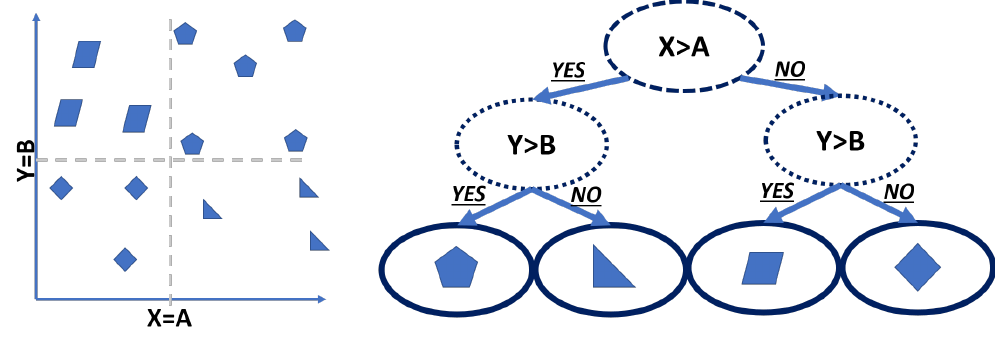
Figure 7. Example of the decision tree of a C4.5